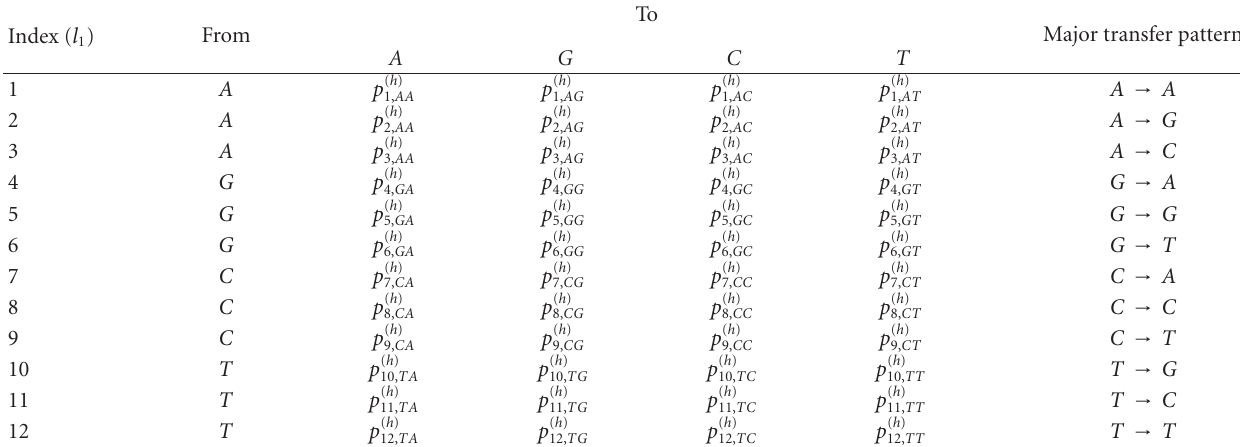
Table 11: 12 kinds of mutagens, each corresponding to major transfer patterns, and the probabilities of di ff erent mutagens on di ff erent transfer patterns.